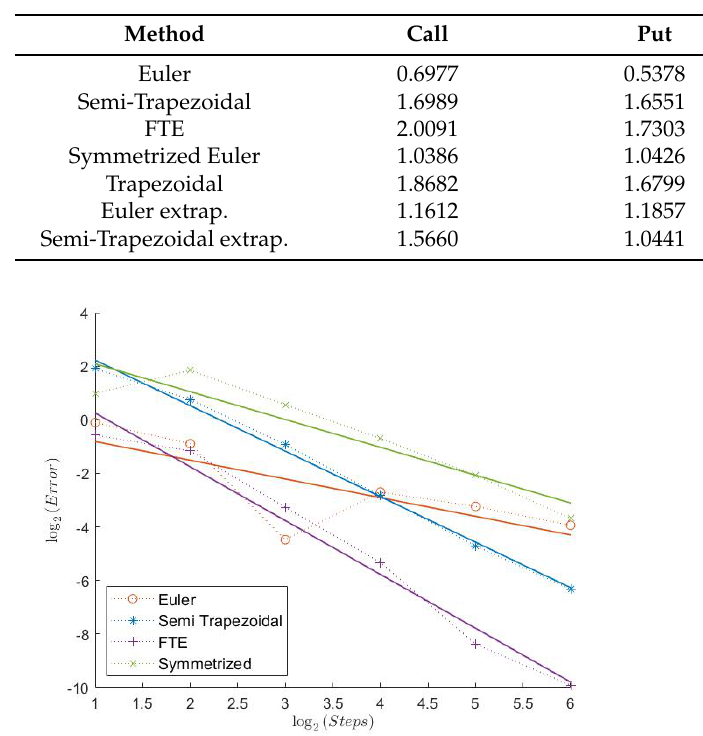
Table 3. Measured convergence rates Model 3.